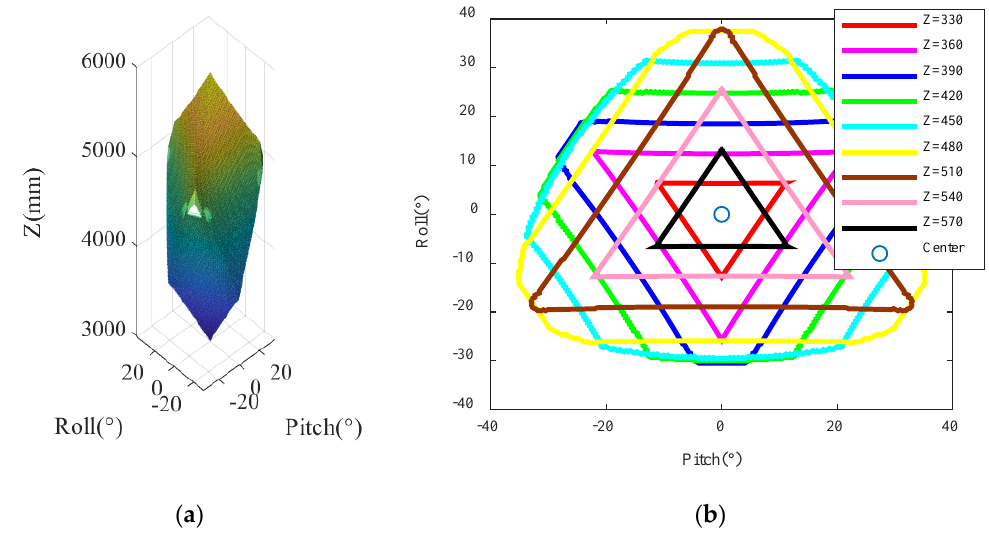
Figure 8. Attitude workspace of 3-SPR compensation platform, ( a ) is the attitude workspace image, ( b ) is a contour map derived from the attitude workspace.